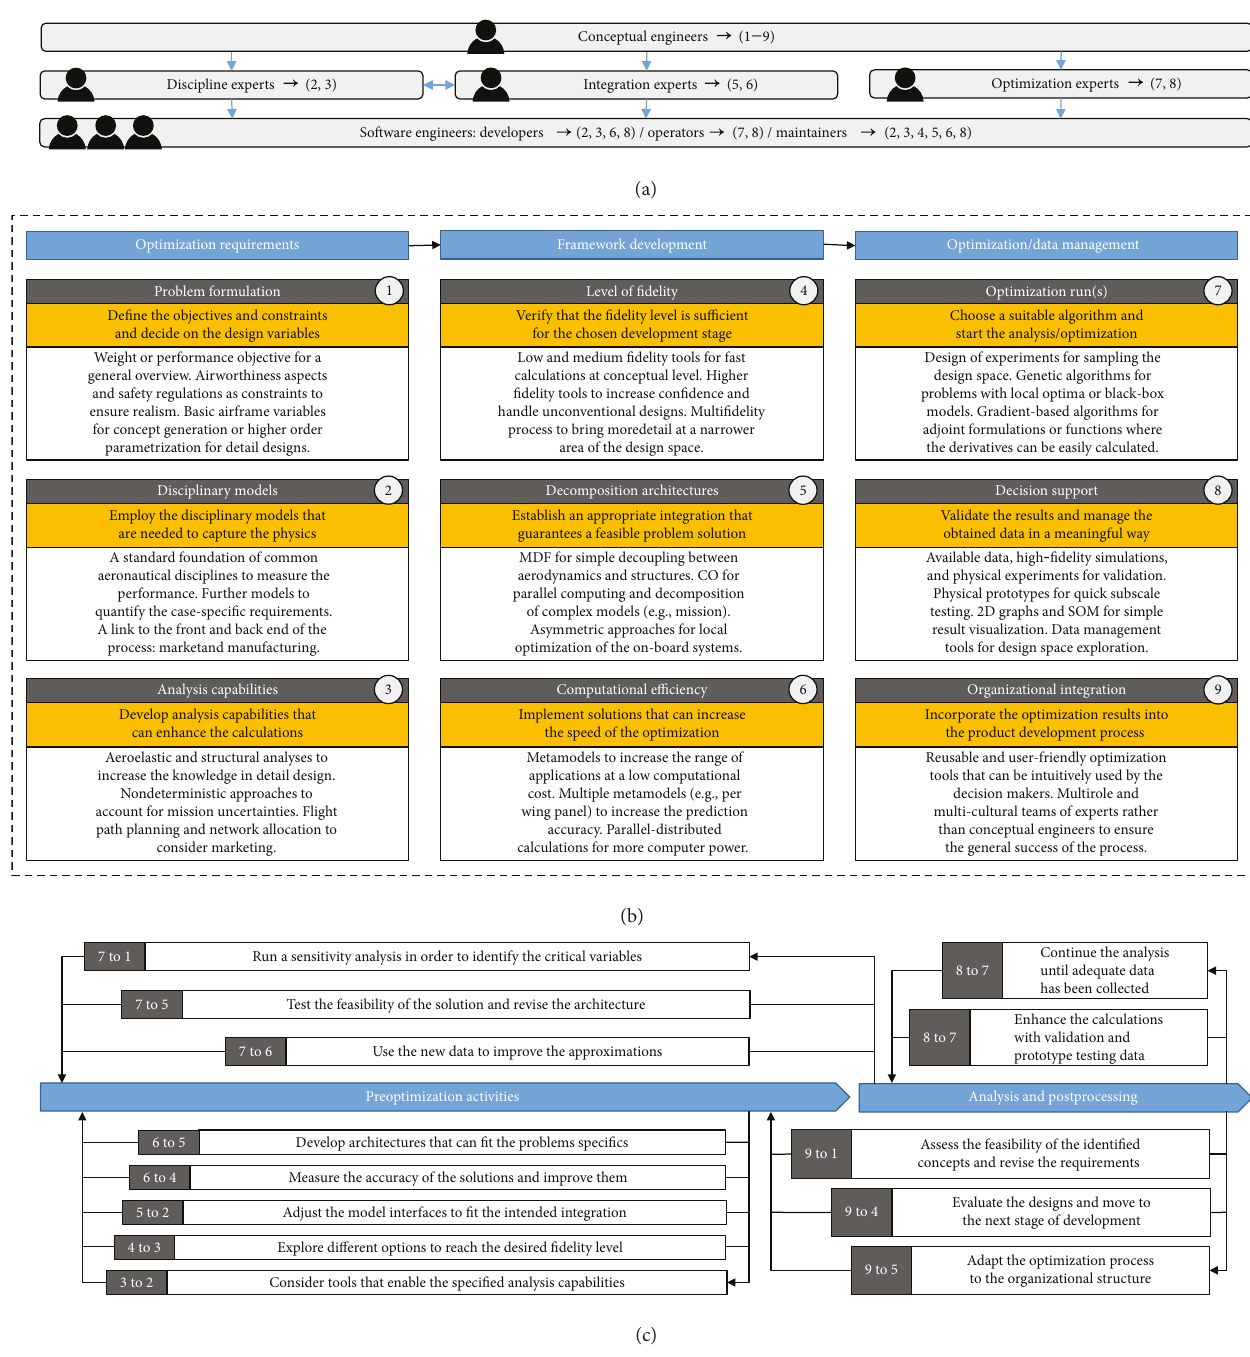
Figure 9: The proposed roadmap for MDO of aerial